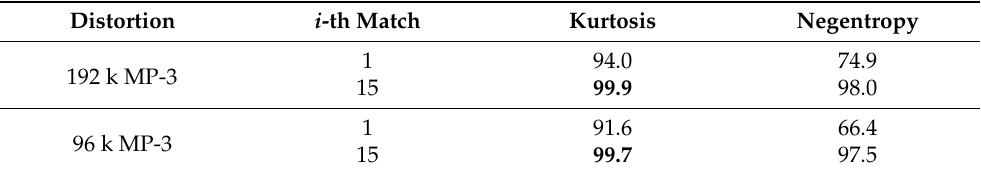
Table 1. Identification accuracy between kurtosis and negentropy in ICA.